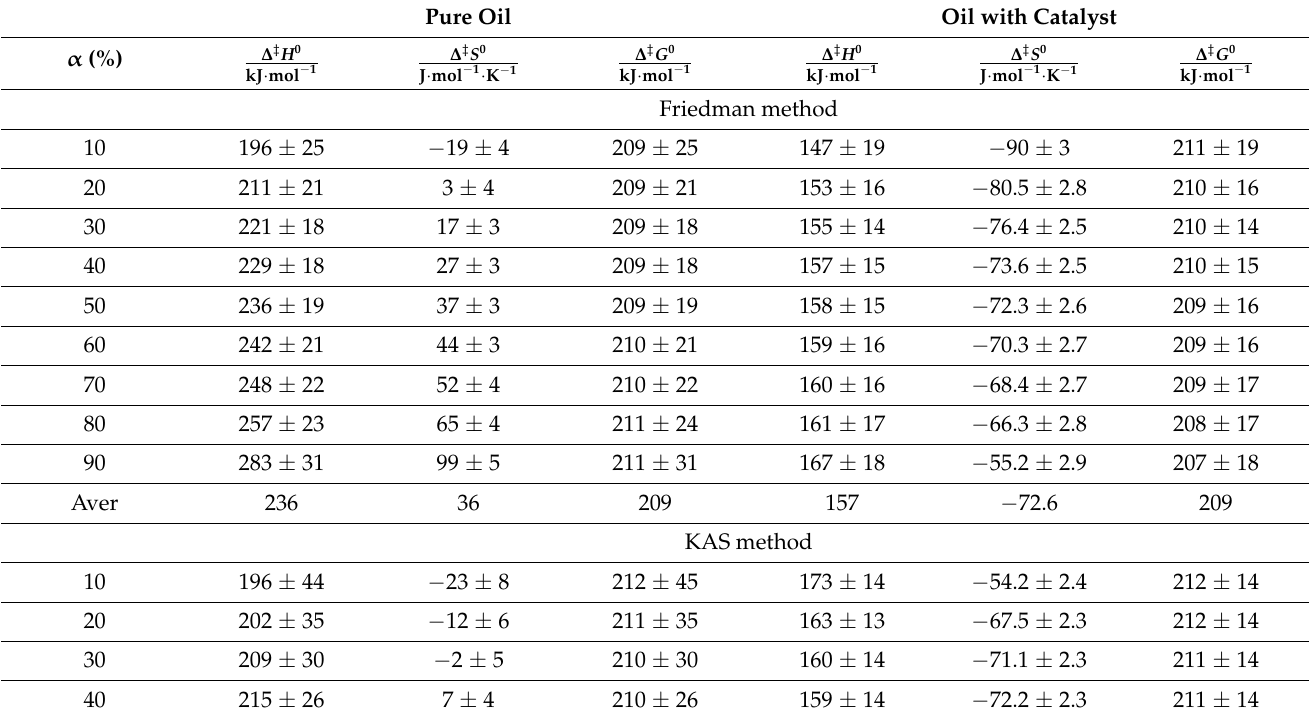
Table 9. Thermodynamic parameters for catalytic and non-catalytic pyrolysis processes based on KAS and Friedman